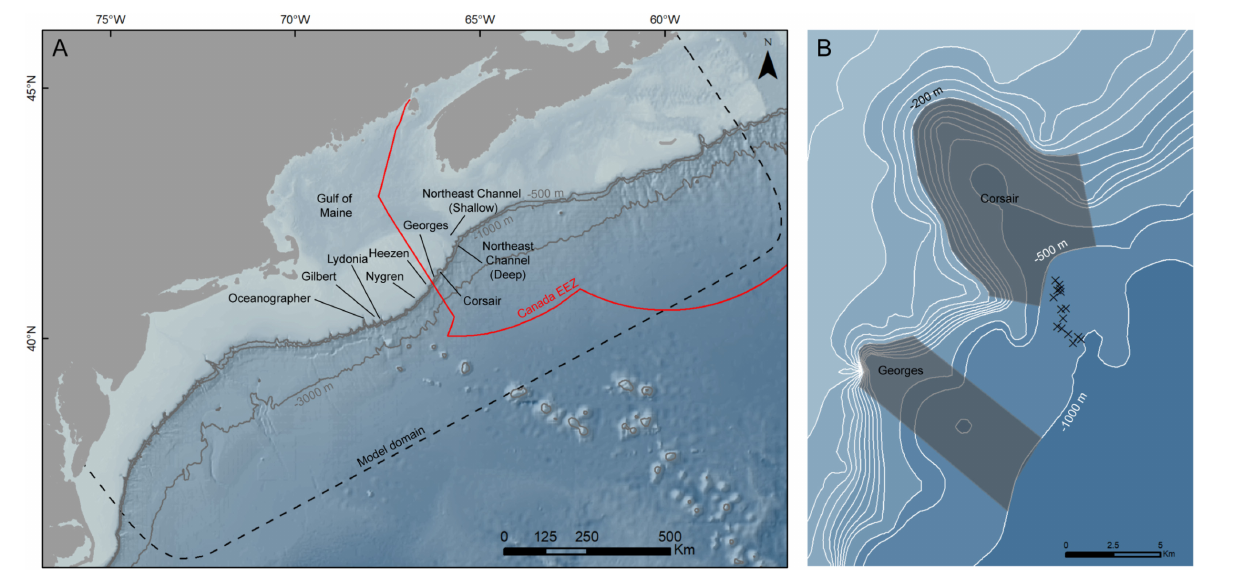
FIGURE 3 | (A) Nine zones of interest along the shelf edge between Northeast Channel (‘NEC’) and southwest Georges Bank. Geographic coordinates of approximate center locations of zones of interest are given in Table 3 . Depth contours in meters. ‘EEZ,’ Exclusive Economic Zone. (B) Corsair and Georges Canyons zones of interest bounded by the 200-m and 1000-m depth contours. Endpoints of tracks ( n = 15) are indicated. Geographic coordinates of endpoints are given in Table 2